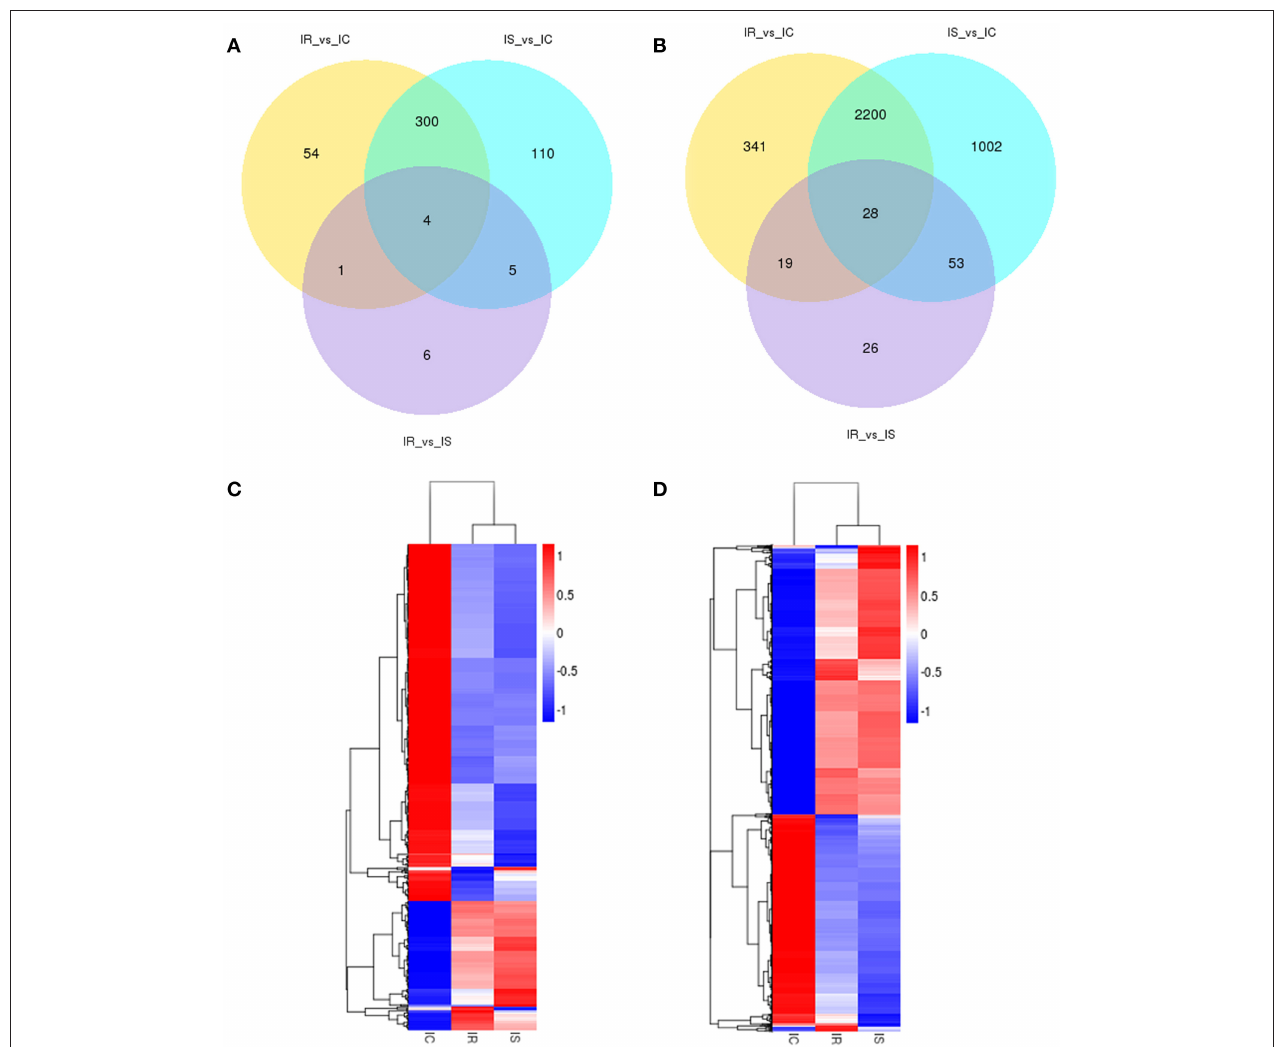
FIGURE 4 | Gene expression number and profiling analyses of differentially expressed lncRNAs and mRNAs among IR, IS, and IC groups after C. perfringens type C infection. Venn diagram of differentially expressed lncRNAs (A) and mRNAs (B) in three comparison groups. Cluster analyses of differentially expressed lncRNAs (C) and mRNAs (D) of 15 piglets infected by C. perfringens type C by hierarchical heat map. Data are expressed as FPKM. Red, relatively higher expression level; Blue, relatively lower expression